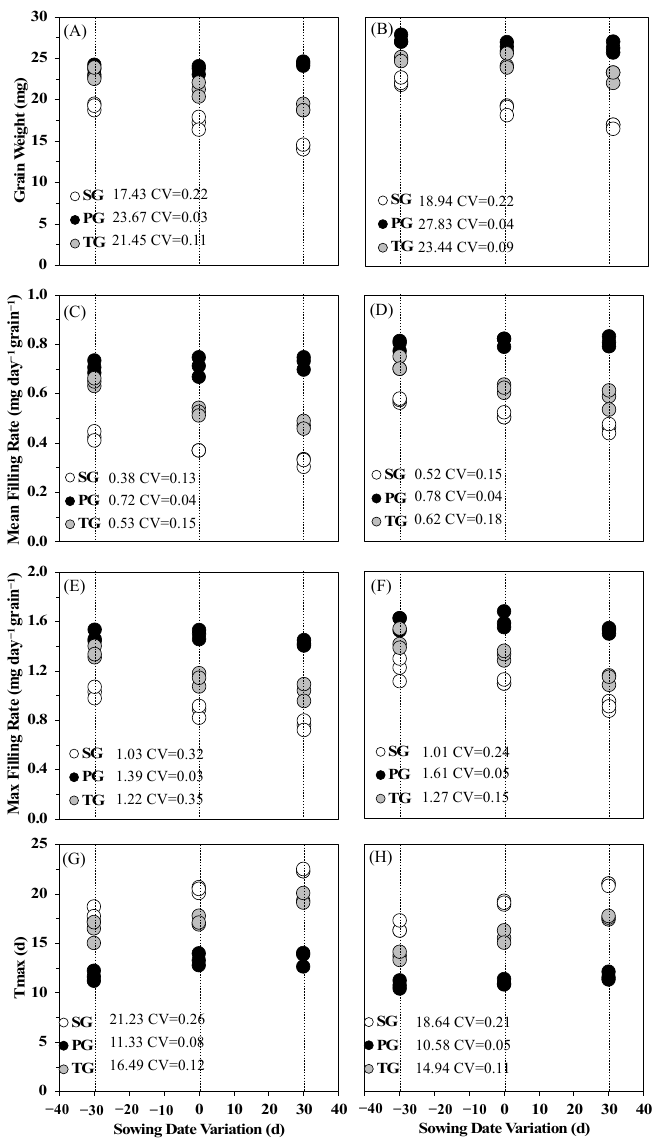
Figure 2. Grain filling characteristics of grains located on different positions and sowing dates of N7 ( A , C , E , G ) and N9108 ( B , D , F , H ). Note : White dots represents grains located on secondary branches (SG); Black dots represents grains located on primary branches (PG); Grey dots represents total grains (TG). CV represents covariance of 3 biological replicates. N7 and N9108 represents Nanjing 7 and Nanjing 9108, respectively.